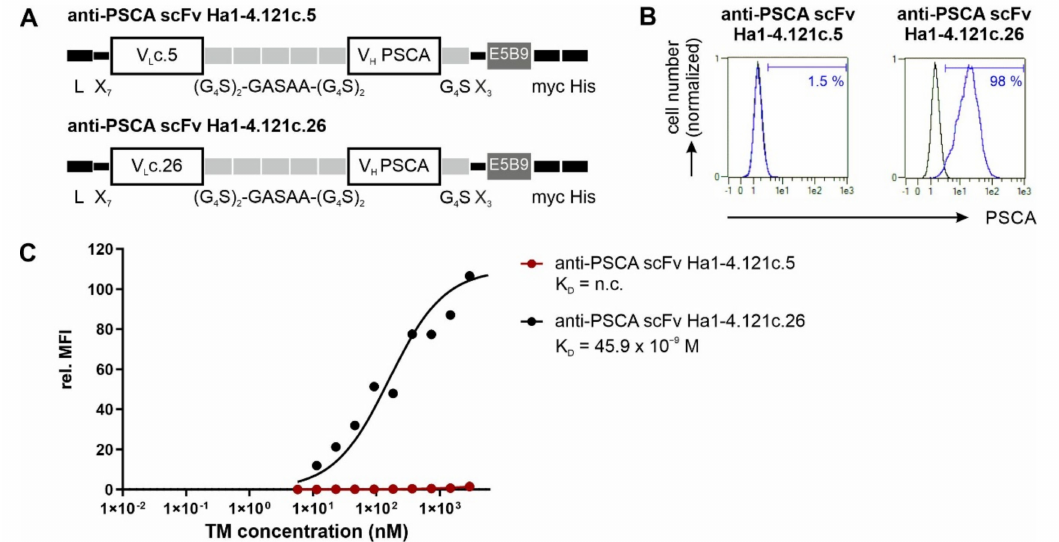
Figure 1. Functional characterization of V L c.5 and V L c.26 of the human anti-PSCA IgG1 Ab Ha1- 4.121. ( A ) Schematic representation of the anti-PSCA scFvs Ha1-4.121 containing either the V L c.5 or V L c.26. C-terminally recombinant Abs were equipped with the E5B9-, myc- and hexahistidine-tag (His-tag). L, leader peptide; V L , variable domain of the light chain; V H , variable domain of the heavy chain; scFv, single-chain fragment variable. ( B , C ) Flow cytometry data of anti-PSCA scFv Ha1- 4.121c.5 and anti-PSCA scFv Ha1-4.121c.26 using PC3-PSCA cells. After incubation of tumor cells with ( B ) 20 ng/ µ L or ( C ) increasing scFv concentrations, the binding of the respective scFv was detected via primary anti-La(5B9) mAb, and secondary goat anti-mouse IgG-PE Ab. ( B ) Histograms show percentage of stained cells (blue graphs) in comparison to the respective negative controls (black graphs). ( C ) For calculation of the apparent affinity of the scFvs towards PSCA, Ab concentrations were plotted against the relative mean fluorescence intensity (rel. MFI) values. Results of one representative experiment is shown; n.c., not